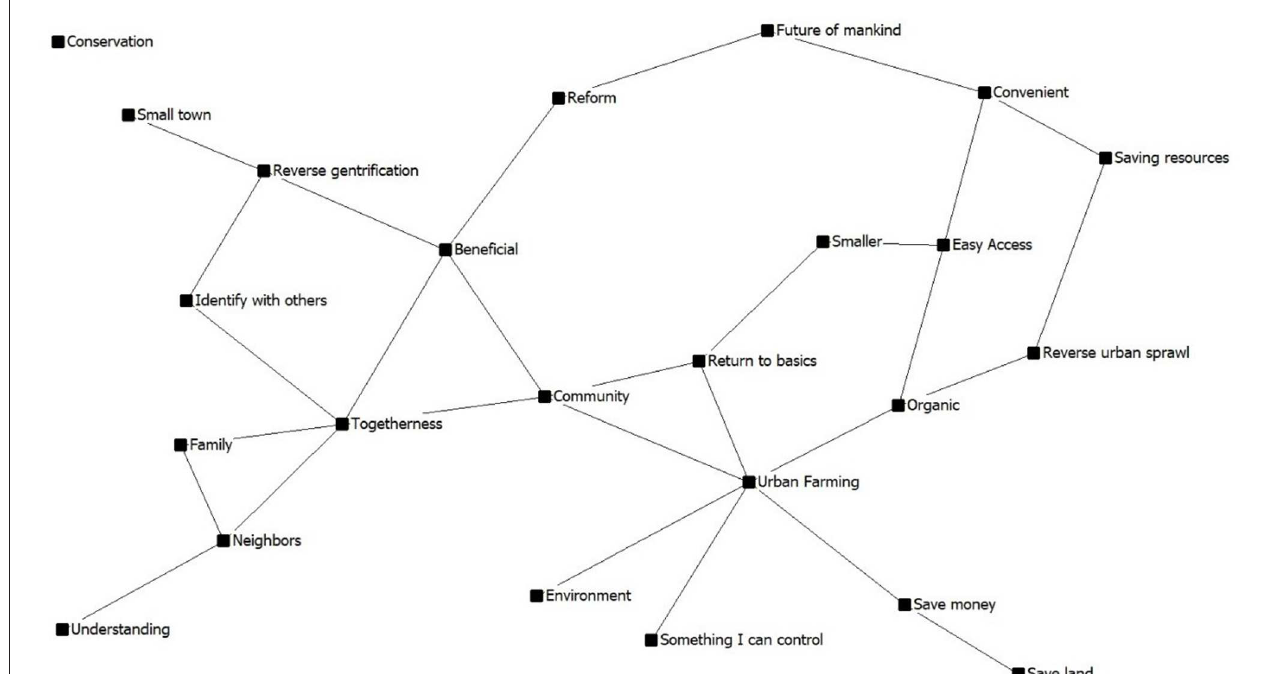
FIGURE 6 | Example of an individual network 4 (location 2, ID